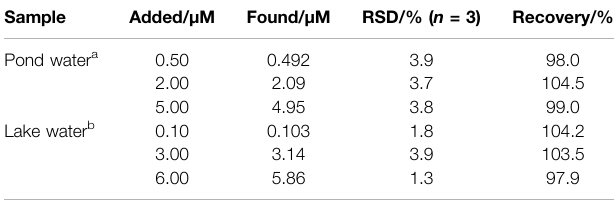
TABLE 2 | Detection of BPA in environmental water